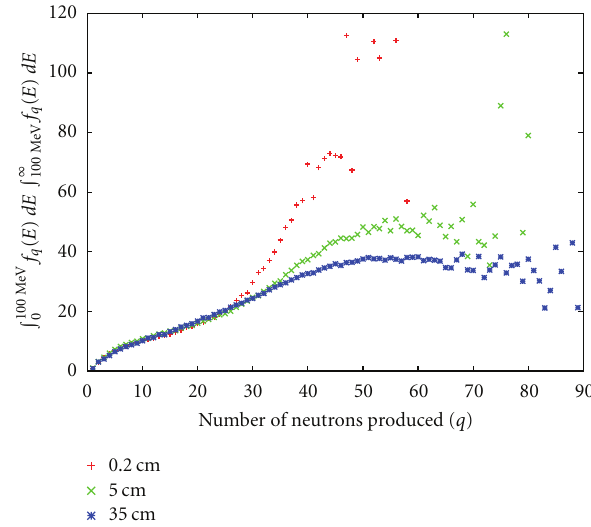
Figure 7: One-particle energy distributions f q ( E ) for di ff erent number of produced neutrons q and average spectrum χ ( E ) calculated for the 5cm thick target.